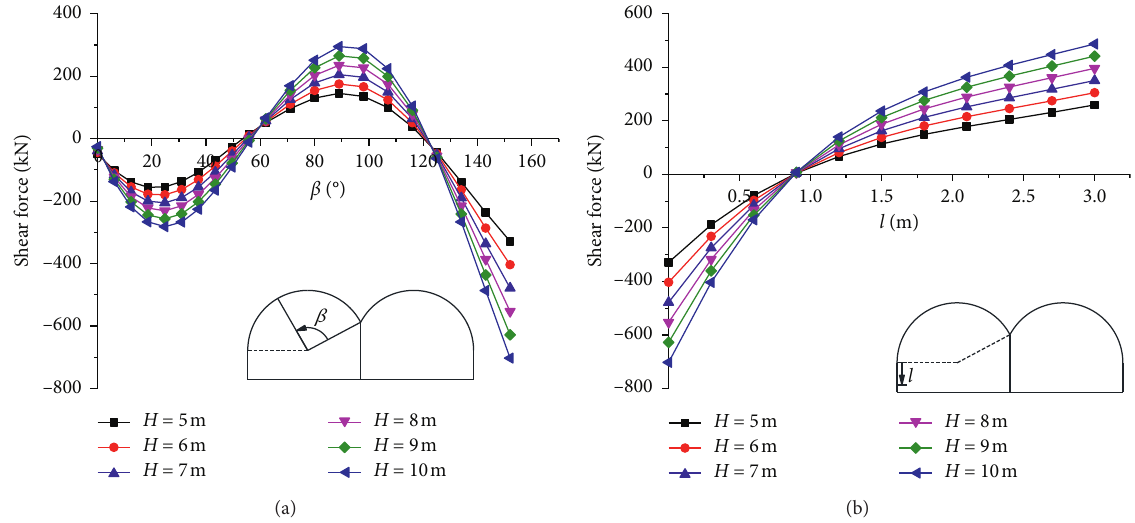
Figure 13: Variations of shear force with ( H ): (a) along the arch ring; (b) along the side